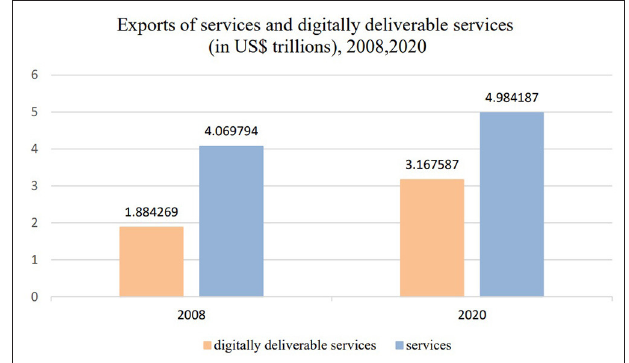
FIGURE 1 | Exports of services and digitally deliverable services (in US$ trillions), 2008, 2020.